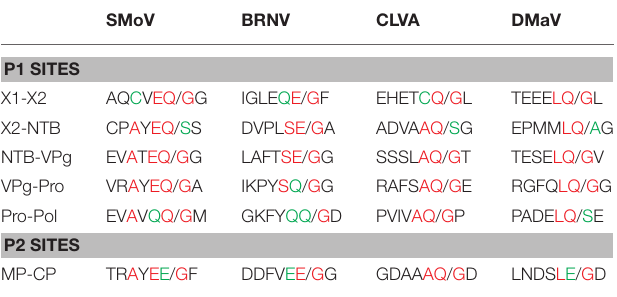
TABLE 2 | Alignment of potential cleavage sites for members of the family Secoviridae . SMoV BRNV CLVA